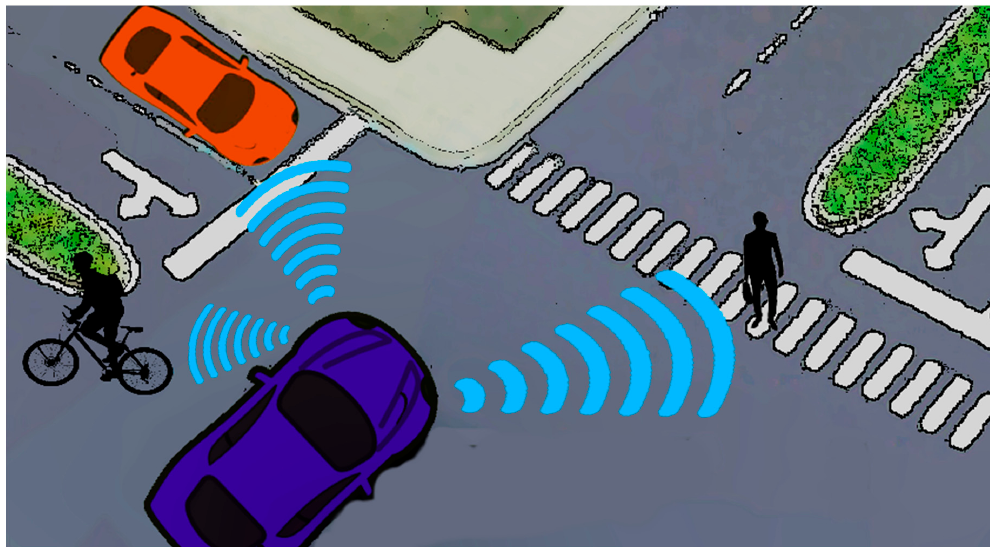
Figure 7. Autonomous vehicle in city driving.